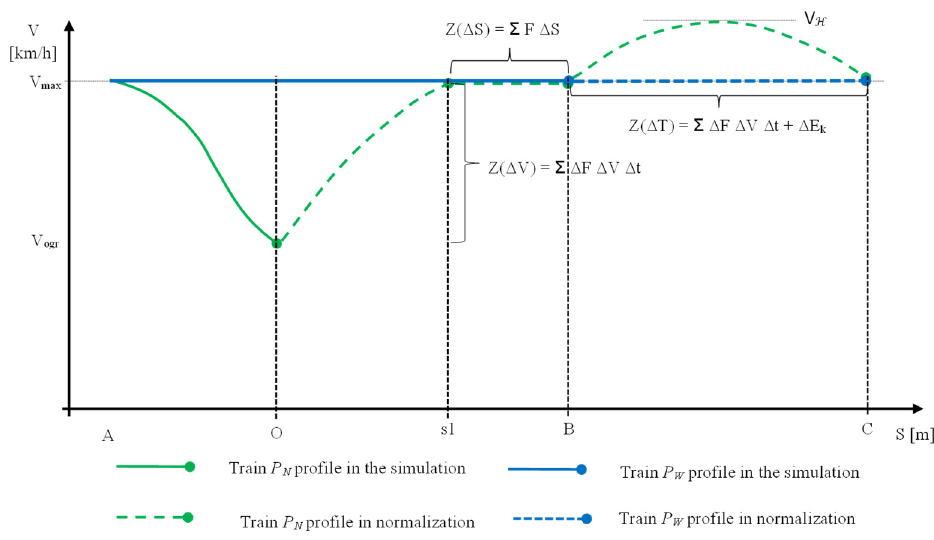
Figure 6. Normalization of simulation results.